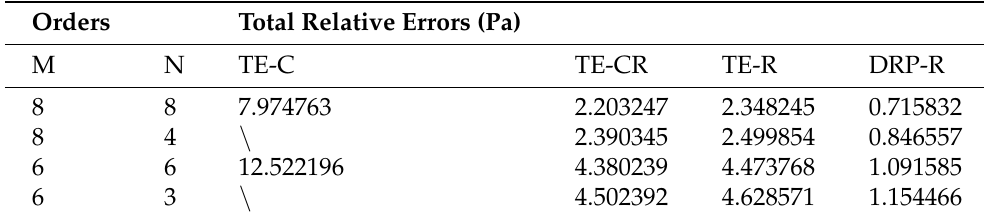
Figure 8. Seismogram at position ( 0,2125 ) (m) of different FD methods. Trace a represents the record of the TE-C method. Trace b represents the TE-R method. Trace c represents the DRP-R method. Trace r represents the reference trace. Trace a-r represents the relative error between trace a and reference trace r . Trace b-r represents the relative error of trace b . Trace c-r represents the relative error of trace c . Table 3. Relative errors of different FD methods in the 2D Sigsbee velocity